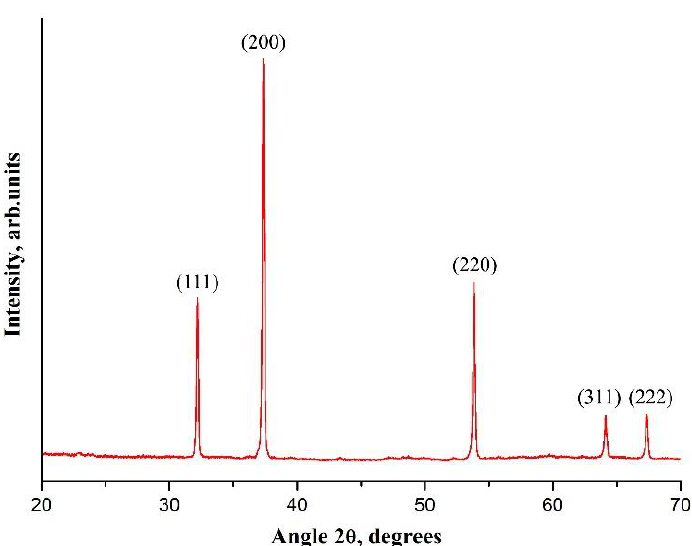
Figure 2. The XRD patterns of electrospun CaAA/PAN fibers annealed at 800 °C.